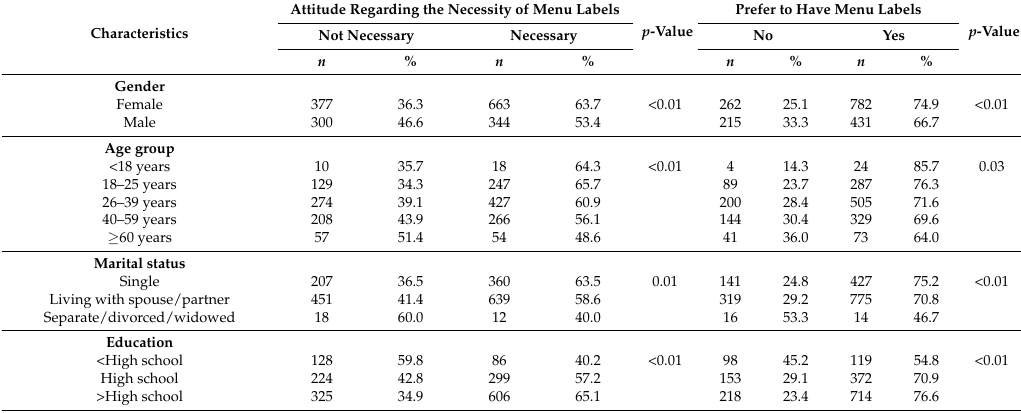
Table 3. Socio-economic characteristics of respondents regarding attitudes and preferences for calories and nutrition